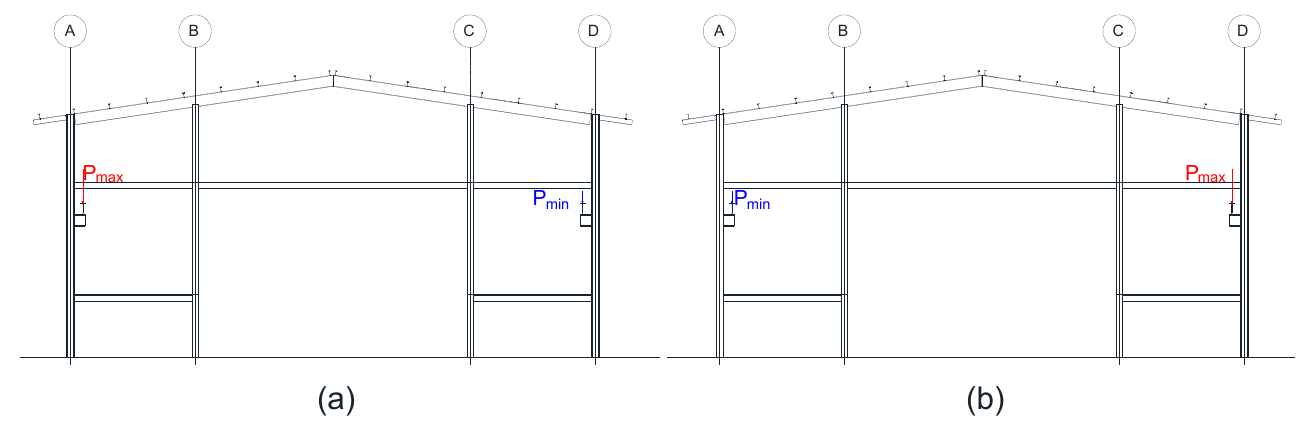
Figure 5. Consideration of overhead crane loads ( a ) Case 1 ( b ) Case 2. A, B, C and D are the structural axis.